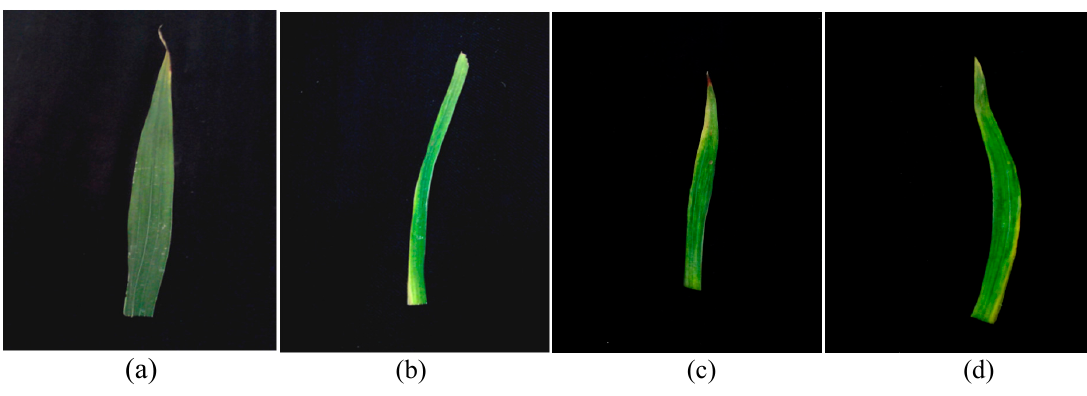
Figure 3. Impact of polyploidy on floral spike formation in gladiolus cv. White Prosperity: Floral spike emerged in control ( a ) however, in treated plants floral spike formation initiated but it did not elongate at 0.1% ( b ) 0.2% ( c ) and 0.3% colchicine concentration ( d ). Along with different irregularities in plant structure, chlorophyll mutation or abnormalities like production of chlorine (Yellowish green) in mutated plants have also been observed. Gladiolus control plants had dark green color leaves but, in all colchicine treated plants, yellowish green color (chlorine) leaves were observed as shown in Figure 4.